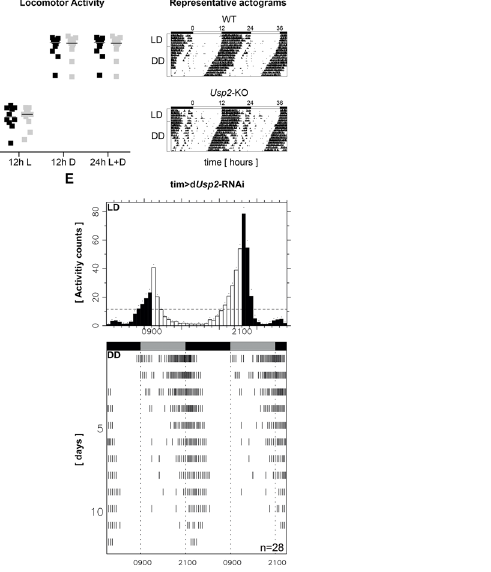
Fig 1. Inactivation of m Usp2 does not affect the circadian endogenous free-running period. A: Mice were housed in individual cages equipped with a running-wheel and entrained for 2 weeks in 12h Light:12h Dark cycles (LD) before being released in constant darkness (DD) for 3 weeks. Endogenous free-running period was calculated by Fourier ’ s analysis. Data are presented as individual values. Black dots: WT; Gray dots: Usp2 -KO, bar = median, n = 10 – 11 animals. B: Locomotor activity in light phase (12h L), dark phase (12h D) and over 24 hours (24h L+D) measured by running-wheel counts was plotted as individual values. Black dots: WT; Gray dots: Usp2 -KO, bar = median, n = 10 – 11 animals. C: 5 days of LD and 12 days of DD are shown on representative actograms of WT and Usp2 -KO mice. D , E: The rhythmic activity patterns of control ( D ) and clock neurons-specific d Usp2 -knockdown ( E ) were studied for 3 days in LD and 12 days in DD. Activity counts were measured during 3 consecutive days in LD. Data are plotted as mean ± standard deviation (SD) of each 30 minutes time interval. Light phase: white bars, dark phase: black bars, dot = SD. Fly activity during 12 days of DD is presented as a representative actogram of each genotype. Subjective day and night periods are indicated above the actogram in grey and black,